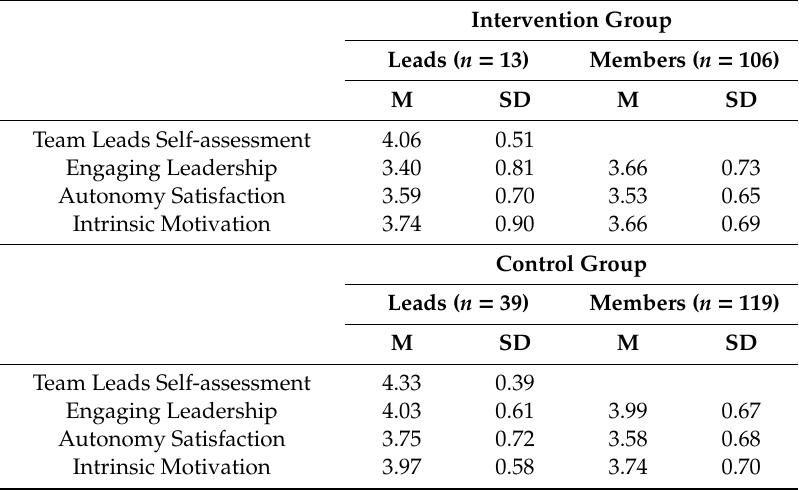
Table 2. Means (M) and standard deviations (SD) at baseline.